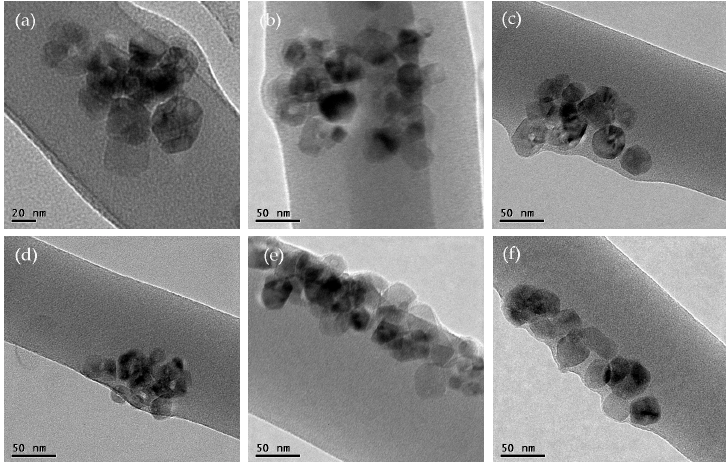
Figure 2. TEM images of PVA/TiO 2 nanofibers prepared by different needles ( a ) 6 mm, ( b ) 16 mm, ( c ) 26 mm, ( d ) 60 mm, ( e ) 100 mm and ( f ) 150